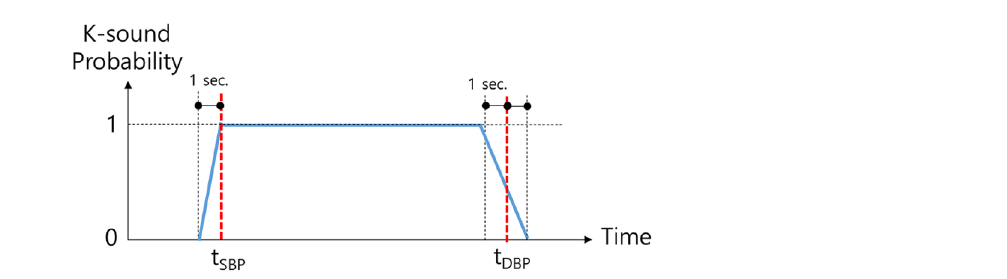
Figure 4. Determining probability labels.